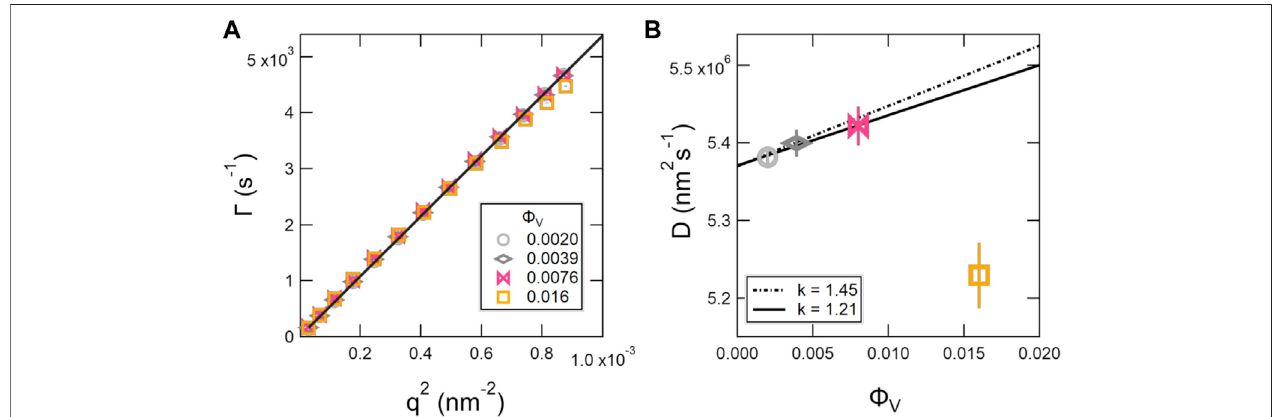
FIGURE2| Decayconstants, Γ extractedfromsingleexponential fi tstotheDLScorrelationfunctionsplottedversus q 2 (A) andcorrespondingdiffusioncoef fi cients, D (B) for diluteSOPC lipid vesiclesolutions.Thesolidlinein (A) isarepresentative linear fi tto Γ = Dq 2 todetermine the D values plottedin (B) . Thelines in (B) correspond to fi tswithavirialexpansionfollowing Eq.6 todeterminediffusioncoef fi cientatin fi nitedilution, D 0 ,wherethesolidlineisthebest fi ttothedataandthedashedlineisthe fi t withthescalingconstantreportedforhardspheres, k =1.45[29].Theerrorbarsrepresentonestandarddeviationandinsomecasesaresmallerthanthesymbols.